Question: Sum up the contents of this chart in one sentence.
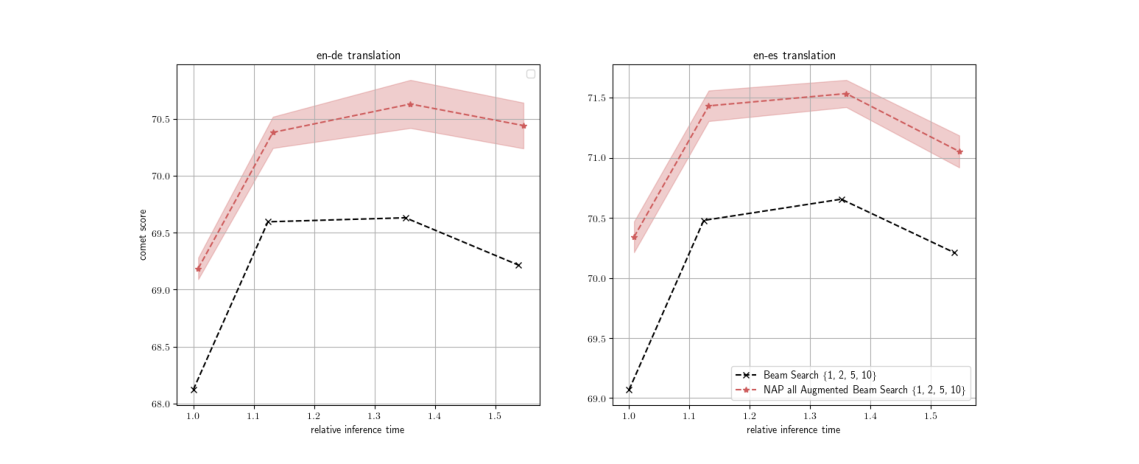
Answer: Modifying encoder outputs using the gradient of a NAP. This shows the overall performance of various beams using an optimal fixed α = 0.50 based on the validation sets. The error represents 1 standard deviation.